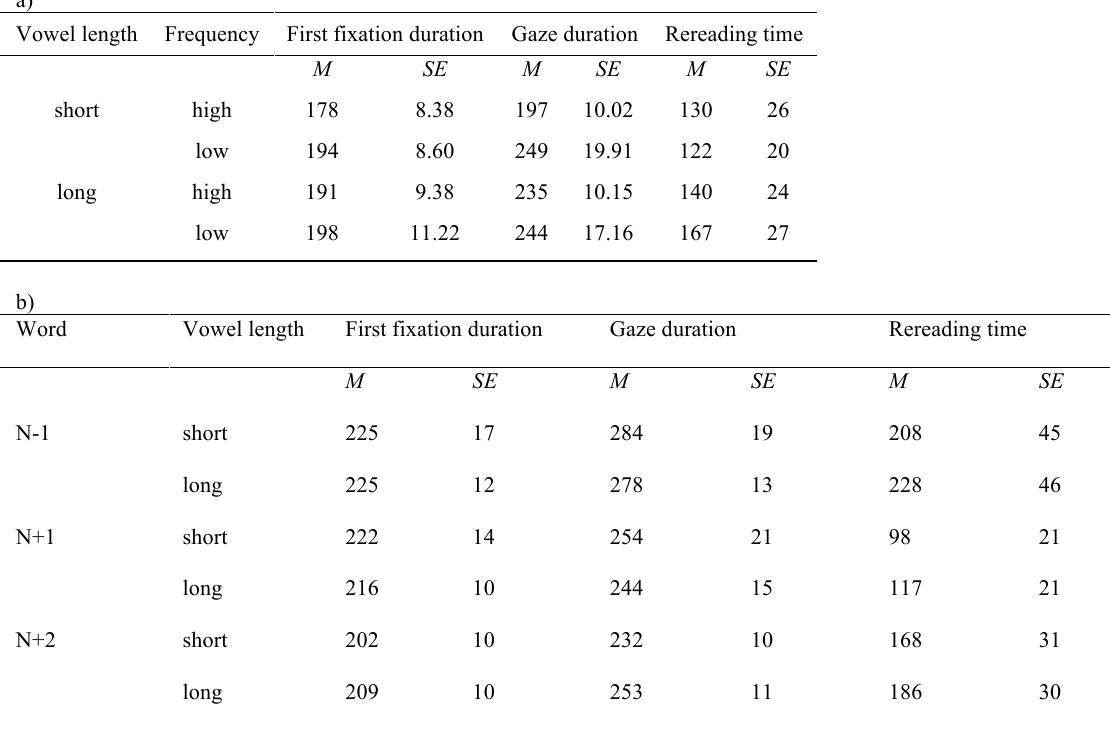
Mean first fixation durations, gaze durations, and rereading time in Experiment 4, a) on target words with short vs. long vowels and of high vs. low frequency, b) on surrounding words as a function of target word vowel length.